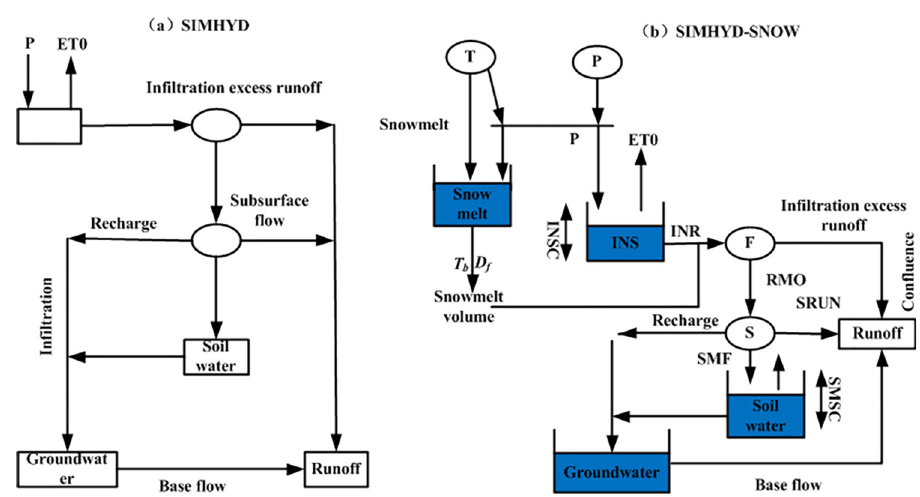
Fig 2. The schematic diagrams of the traditional SIMHYD model and the improved SIMHYD-SNOW model.